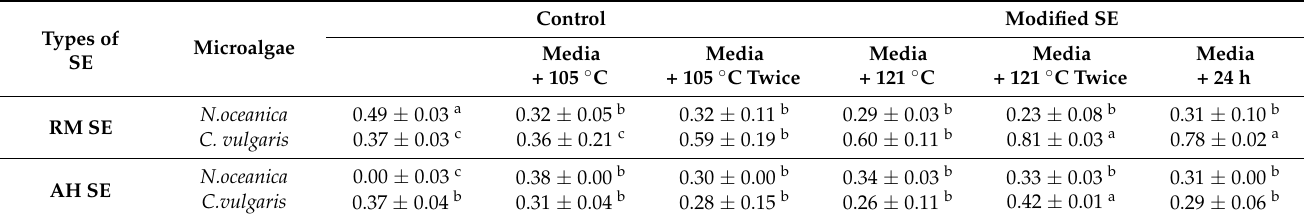
Table 3. The maximum OD of N. oceanica, C. vulgaris on control, 105 ◦ C, 105 ◦ C twice, 121 ◦ C, 121 ◦ C twice and 24 hours’ soil extraction (SE) from Raja Musa Forest Reserve (RM) and Ayer Hitam Forest Reserve (AH).